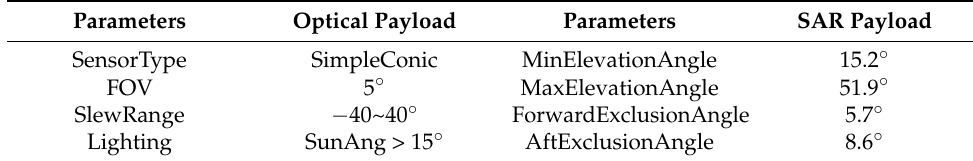
Table 2. Payload